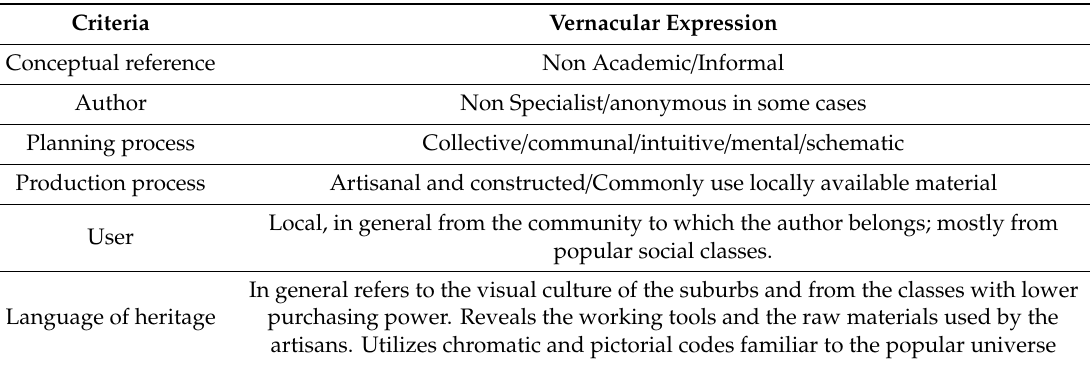
Table 3. The Simple dimension of what constitutes vernacular architecture, adapted based on [68].